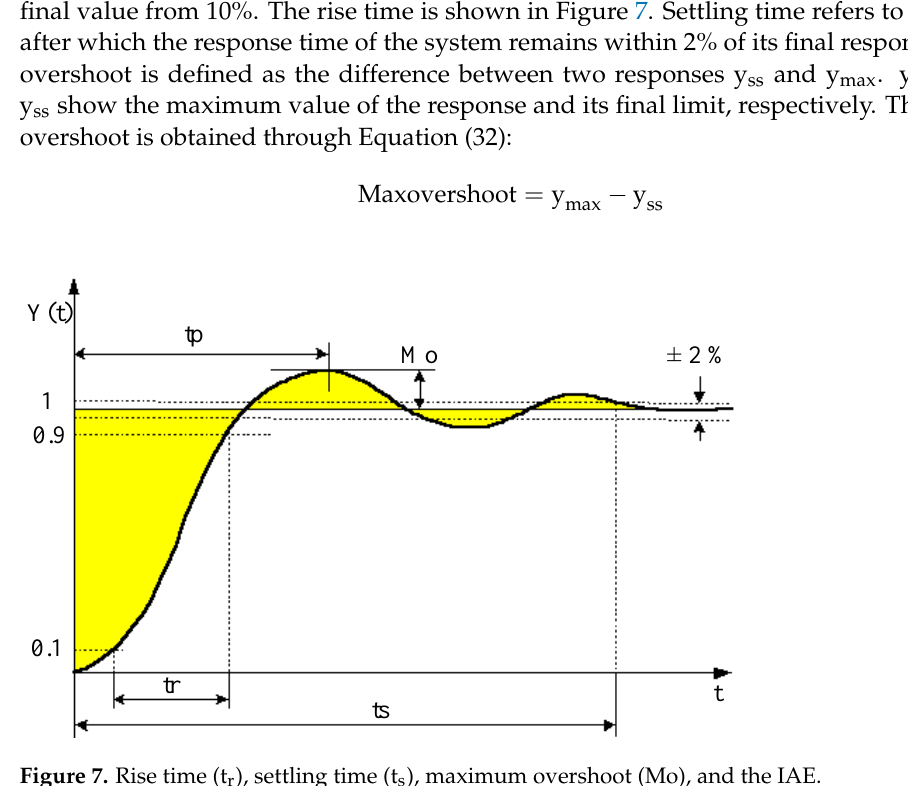
Figure 7. Rise time (t r ), settling time (t s ), maximum overshoot (Mo), and the IAE. The integral of the absolute value of the error is defined through Equation (33).